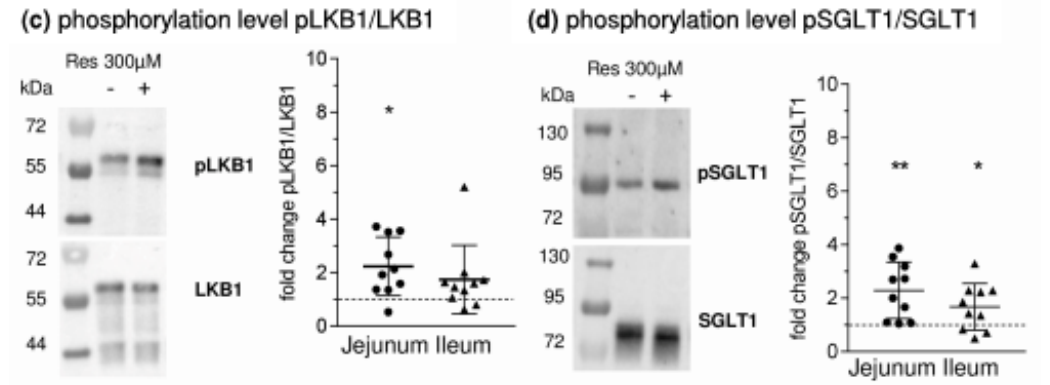
Figure 5. Changes in the phosphorylation levels of ( a ) PKA substrates ( b ) AMPK ( c ) LKB1 ( d ) SGLT1 after incubation with Resveratrol (300 µM, mucosal). One exemplary Western blot is shown together with the relative changes when setting the phosphorylation levels of control samples at 1. MW ± SD ( n = 10), tested against 1 using one sample t-tests. * p ≤ 0.05, ** p ≤ 0.01.